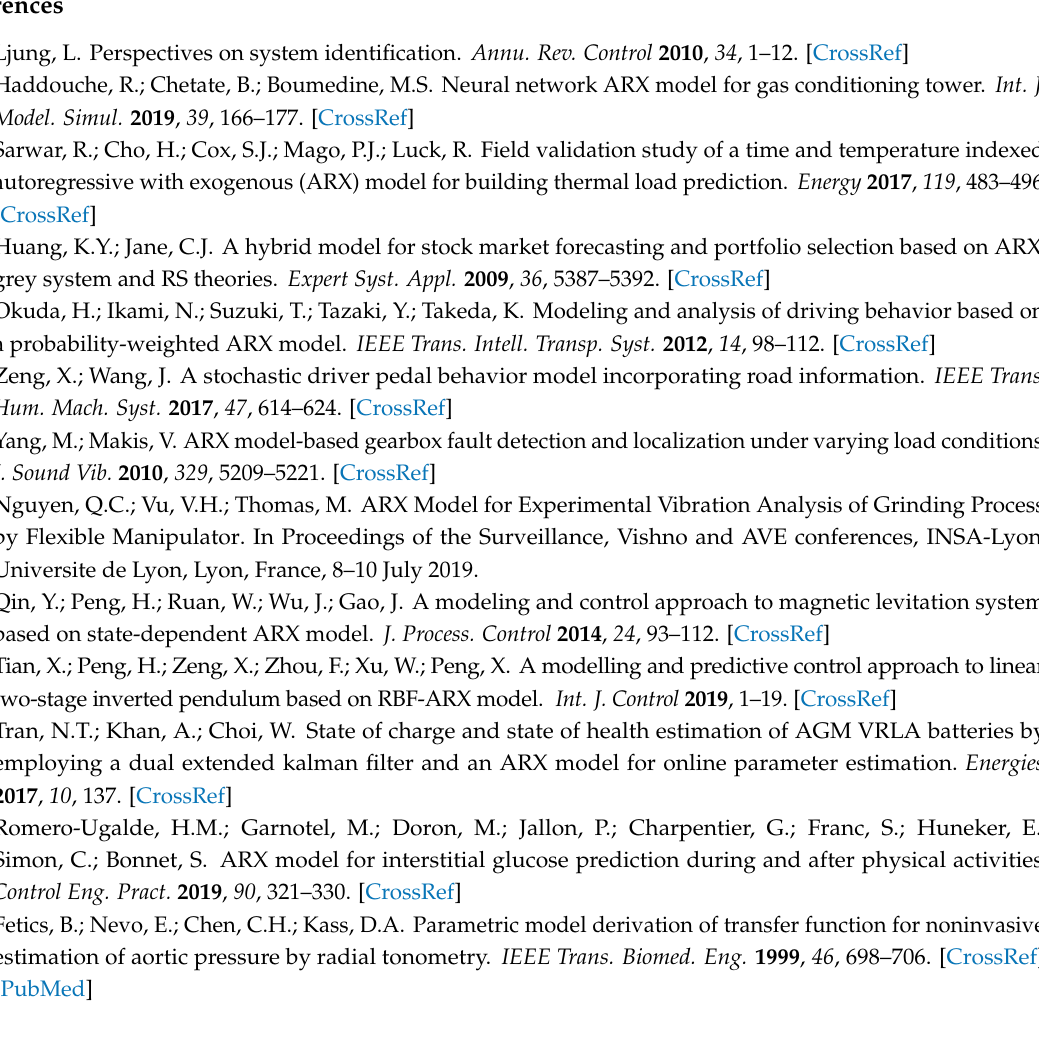
8/s1 , Table S1. Results obtained for the solid mesh size test, Figure S1: Validation test for the solid mesh selection, Figure S2. Meshes distribution -sections- within the layout., Figure S3. Validation test for the fluid mesh selection, Figure S4. Displacement observed in the top leaflet after T= 3s, Figure S5. The behavior of the leaflet indicates oscillation moments increased as soon as the elastic modulus did, whereas the magnitude of these reduces with a higher E value, Table S3. Displacement of each E under different forces applied, Figure S6. Reconstruction of the signals using the ARX model for E = 0.1 MPa. In (a) we have the opening area and in (b) the pressure difference, Table S4. Coefficients obtained for (a) Sv and (b) DP corresponding to E = 0.1 MPa., Figure S7. Reconstruction of the signals using the ARX model for E = 1 MPa. In (a) we have the opening area and in (b) the pressure difference, Table S5. Coefficients obtained for (a) Sv and (b) DP corresponding to E = 1 MPa., Figure S8. Reconstruction of the signals using the ARX model for E = 3.16 MPa. In (a) we have the opening area and in (b) the pressure difference, Table S6. Coefficients obtained for (a) Sv and (b) DP corresponding to E = 3.16 MPa., Figure S9. Reconstruction of the signals using the ARX model for E = 10 MPa. In (a) we have the opening area and in (b) the pressure difference, Table S7. Coefficients obtained for (a) Sv and (b) DP corresponding to E = 10